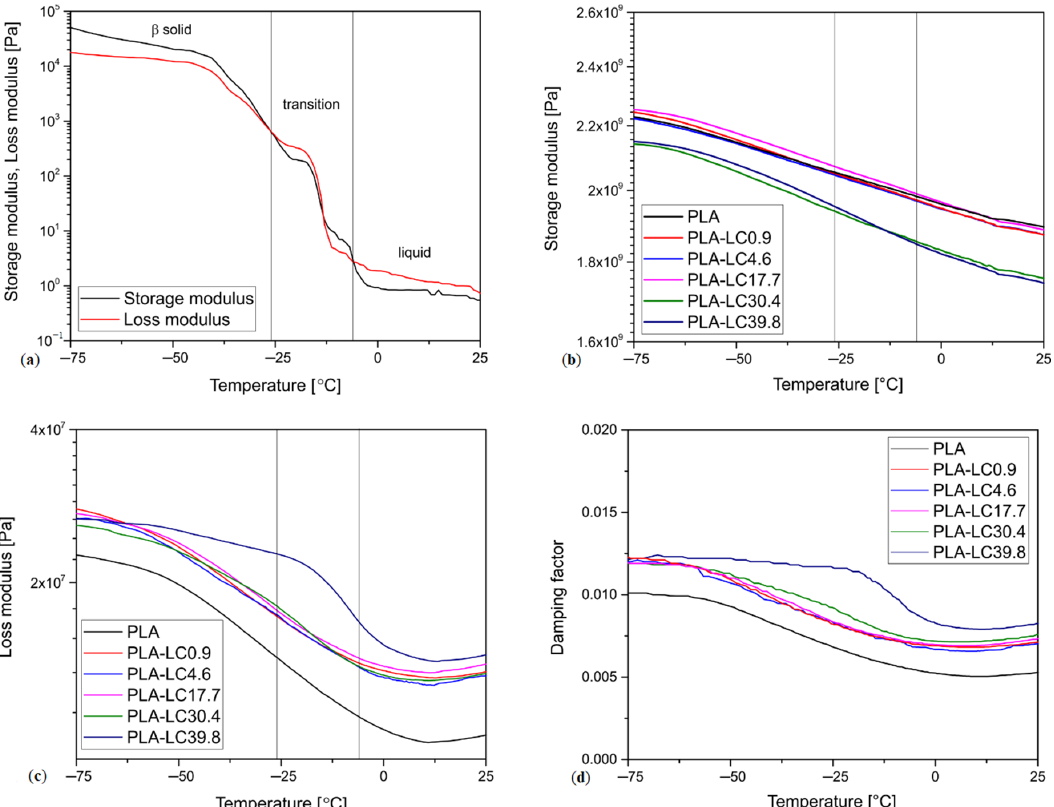
Figure 2. Changes of ( a ) storage and loss moduli of the linseed oil, determined by oscillatory rheology, ( b ) loss modulus of the polymeric samples ( c ) storage modulus and ( d ) damping factor of the polymeric samples in function of temperature, determined by DMA.